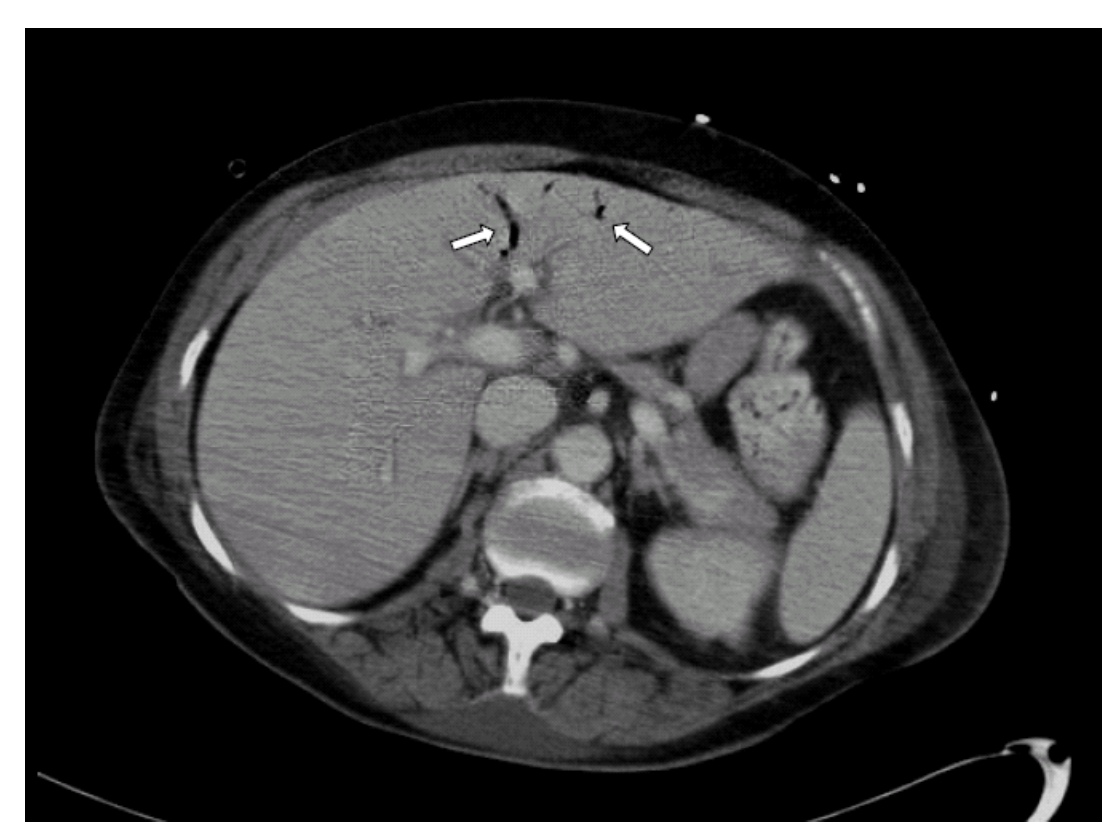
FIGURE. CT of the abdomen showing hepatic portal venous gas (see